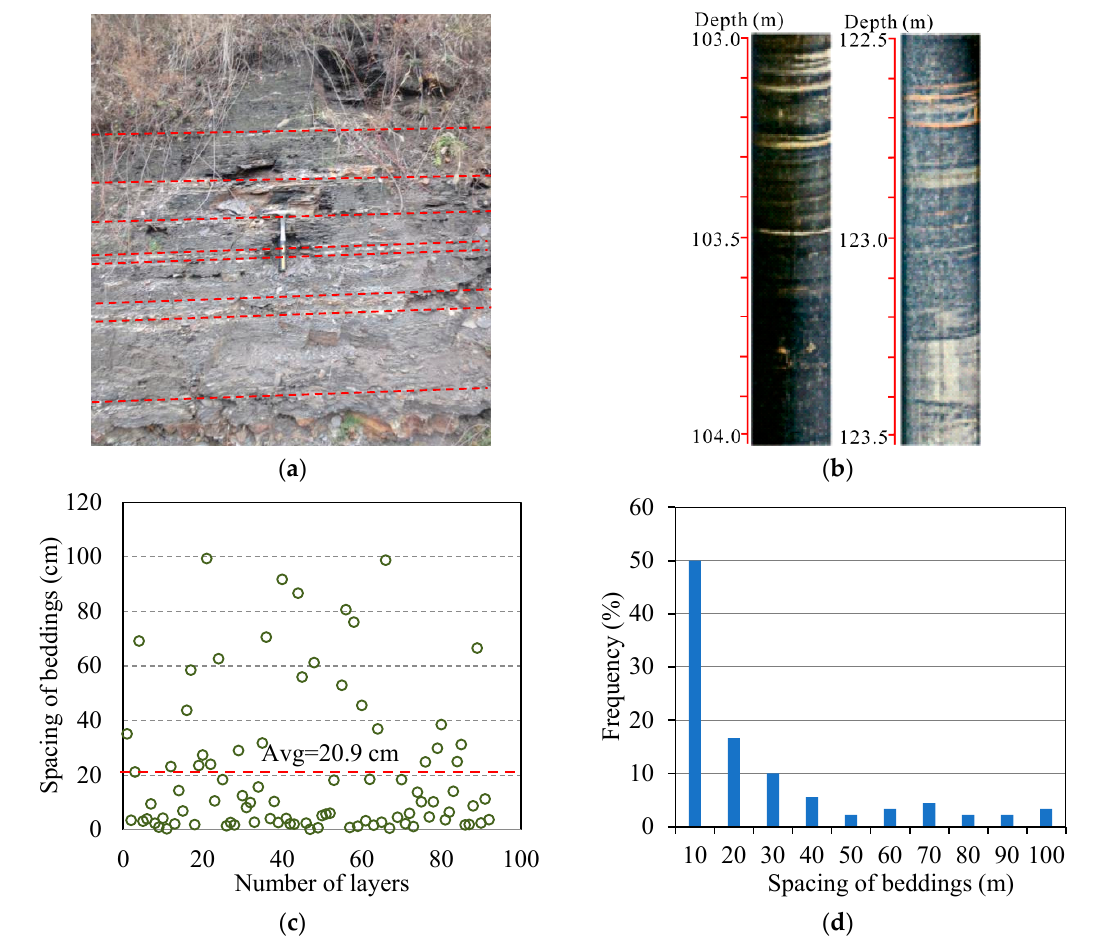
Figure 2. Characteristics of beddings in the Chang 7-2 shale: ( a ) distribution of beddings at an outcrop; ( b ) downhole camera image from a well [45]; ( c ) spacing of beddings based on a total of 90 mapped layers; ( d ) distribution of spacing of beddings.